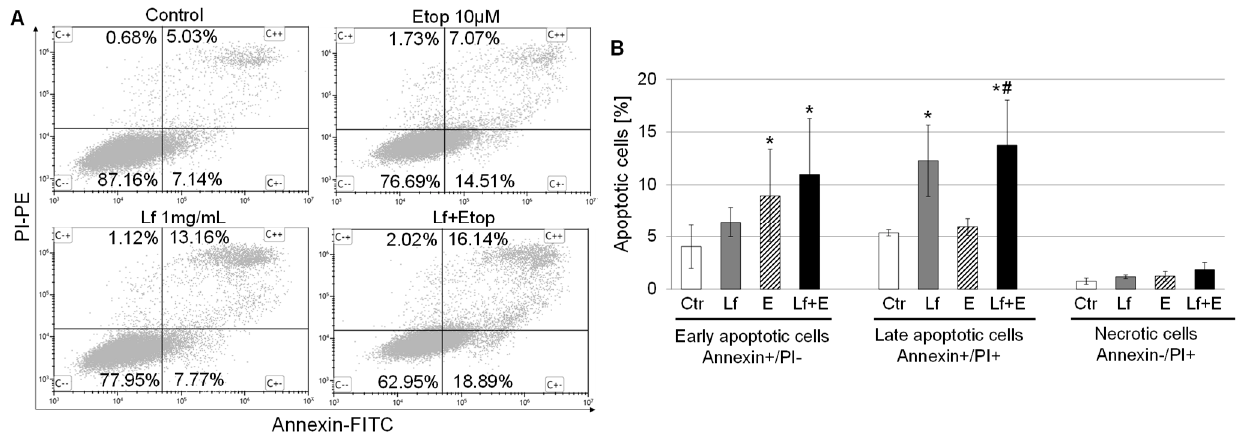
Figure 5. Effect of rhLf in combination with etoposide on A549 cell apoptosis. ( A ) Representative plots of flow cytometry analysis of Annexin V and PI staining of the control and cells after treatment with rhLf (Lf) and etoposide (E) alone or the combination (Lf + E) at indicated concentrations for 24 h. Viable cells (Annexin − /PI − ), early apoptotic cells (Annexin+/PI − ), late apoptotic cells (Annexin+/PI+), necrotic cells (Annexin − /PI+). ( B ) The bar graph shows the quantification of early and late apoptotic cells, and necrotic cells in response to indicated treatments. The values represent the mean ± SD of four experiments. * p < 0.05 compared to control (Ctr) and # p < 0.05 compared to etoposide alone (E).